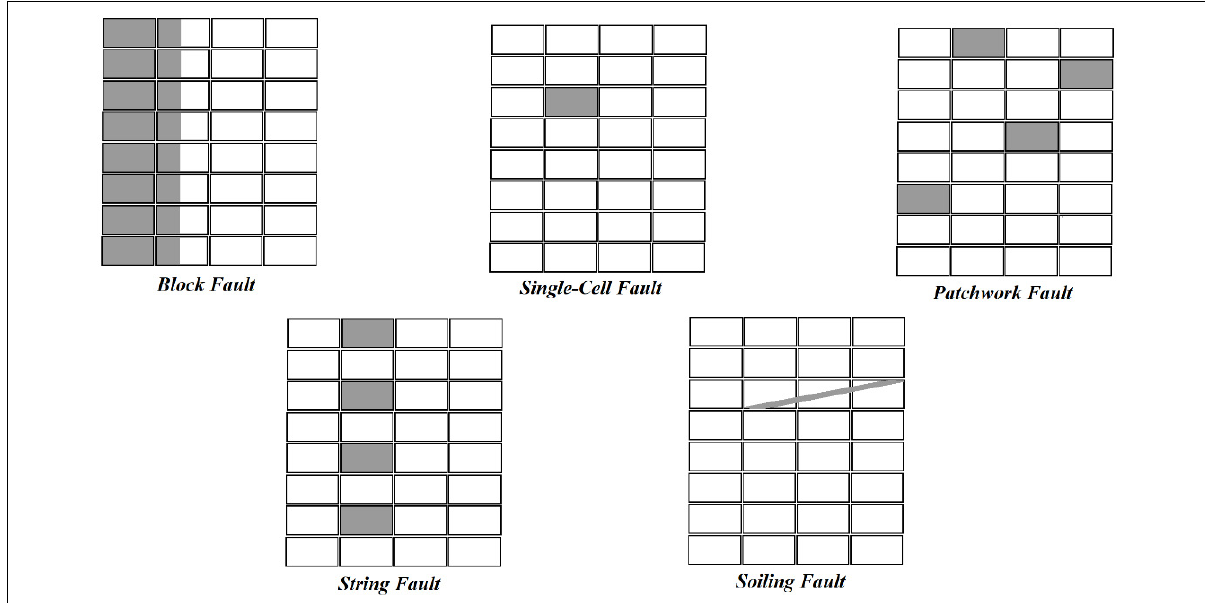
Figure 1: Classification of photovoltaic module